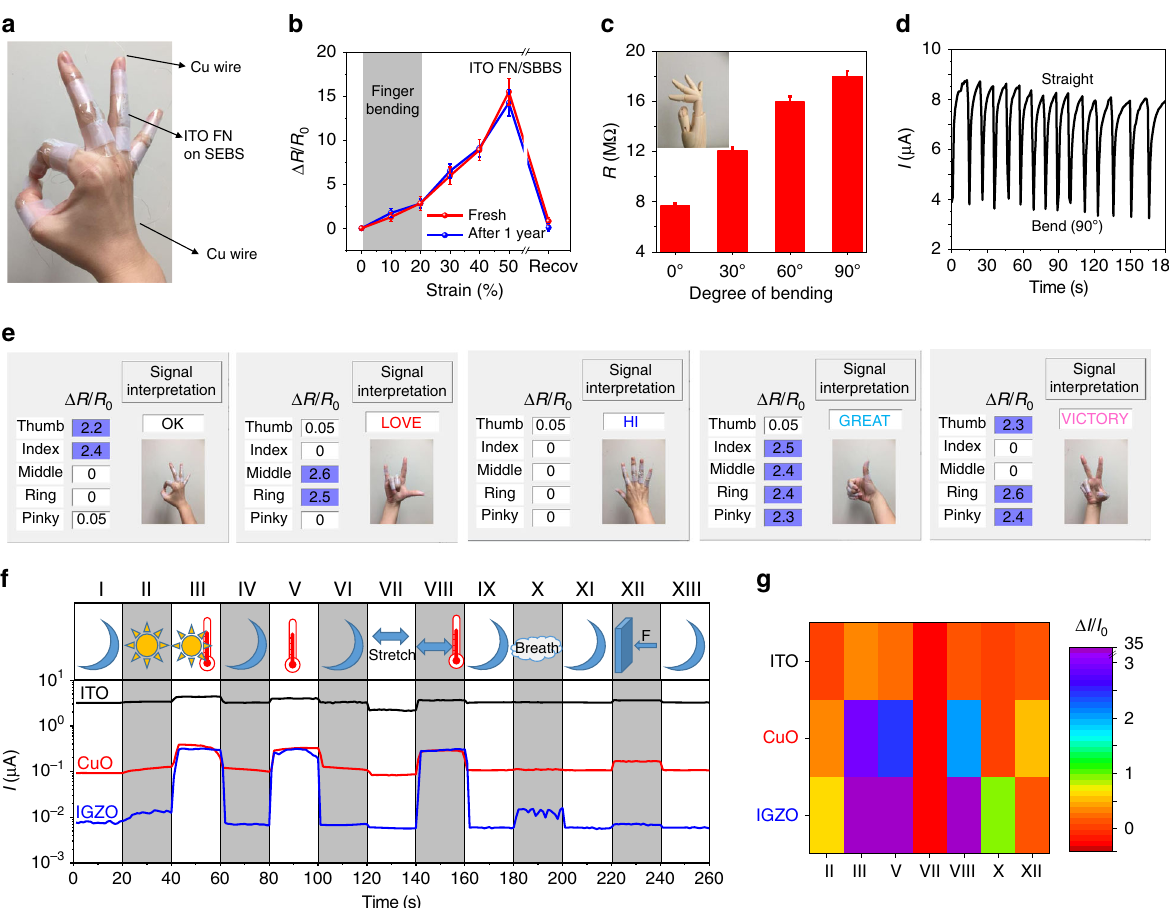
Fig. 5 Wearable ITO FN-based devices and monolithically integrated devices for sensing and differentiating stimuli. a Photograph of a hand fi tted with ITO FN-based sensing devices. b Resistivity change of fresh and 1-year-storage ITO FN-based device under different strains. The gray region indicates the strain range when bending fi ngers. c Electrical resistance of ITO FN-based devices under different degrees of fi nger bending. d Cycling test for wearable ITO FN-based devices bending from 0° to 90°. e Demonstration of an array of strain sensors placed on a hand to translate gestures. Box is in light blue when the change of electrical resistance is >2. f Real-time simultaneous sensing of ambient solar light (AM 1.5 G illumination), temperature (~40 °C), stretching (~10% strain), exhaled gas, and pressure (10 kPa), with an integrated IGZO, CuO, and ITO e-skin. g Relative current change of IGZO, CuO, and ITO resistors under different